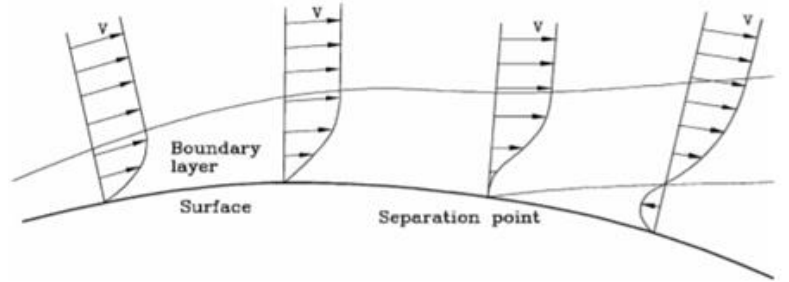
Figure 1. Velocity distribution perpendicular to the surface with subsequent flow separation [3].